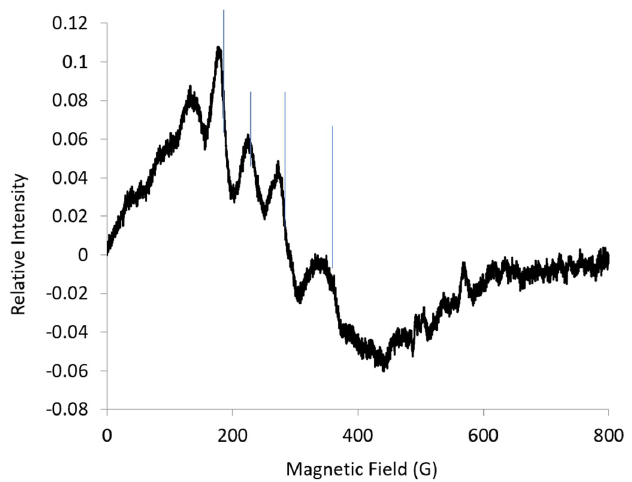
Figure 3. L-band (1.37 GHz) EPR spectrum for CoEDTA (1 mM): temp., 18 K; microwave power, 8 dB; 25 scans averaged. Vertical lines mark four hyperfine lines.